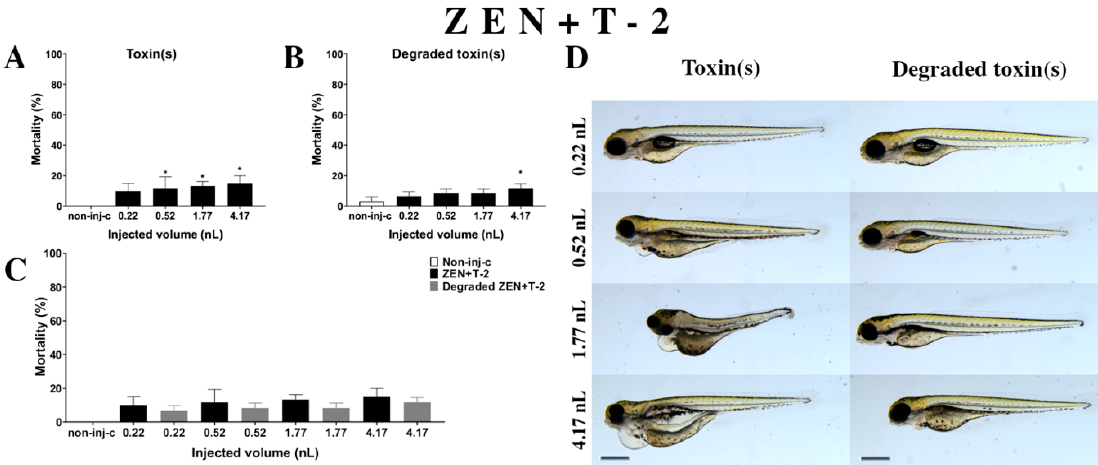
Figure 7. Effects of ZEN+T-2 mixture ( A ) and their degradation products ( B ) by the Rhodococcus erythropolis NI1 strain on 120 hpf zebrafish embryos. Mortality data are expressed as mean ± SD from three independent experiments in triplicate. Kruskal–Wallis followed by Dunn’s post-hoc test and Mann–Whitney test were used. Mortality values were compared to the non-injected control (non-inj-c) (* p < 0.05); lethality results of initial ZEN+T-2 were compared to the degradation products of the ZEN+T-2 mixture ( C ). ZEN+T-2 and their degradation products induced developmental dysfunctions ( D ) in zebrafish embryos examined at 120 h. Representative phenotypic lesions of ZEN+T-2 were tail deformities, pericardial and yolk edema, head and lens distortion, and swim bladders were not developed at 0.52, 1.77, and 4.17 nL; sublethal effects of their degradation products were pericardial and yolk edema, and swim bladders were not developed at 0.52, 1.77, and 4.17 nL. Scale bar: 1 mm. Phenotypes of treated groups were compared to the non-injected control (non-inj-c) (Figure 1C). Quantitative data of developmental dysfunctions in zebrafish embryos are in the Supplementary Materials (Supplementary Table